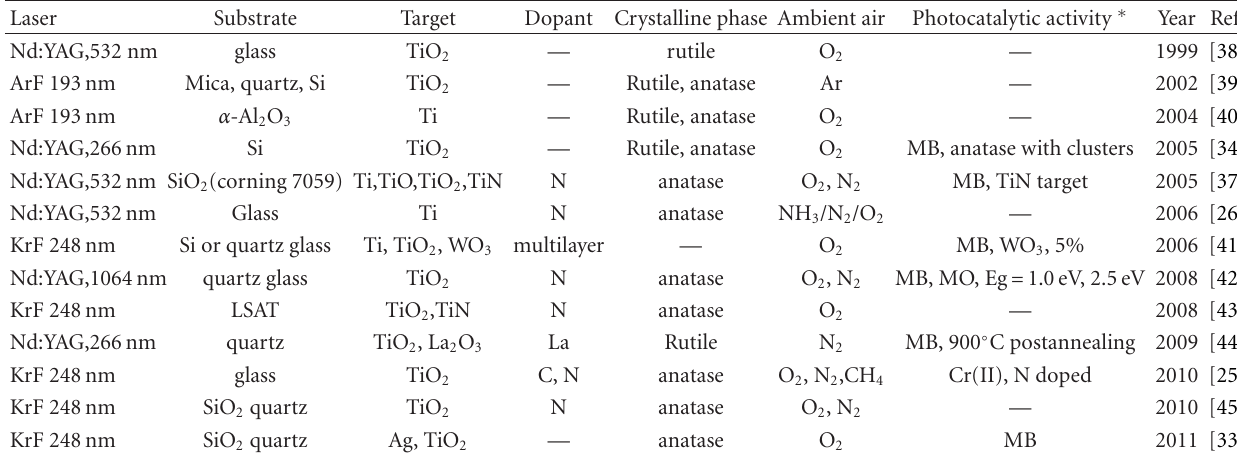
Table 1: Preparation of TiO 2 thin films by PLD method.